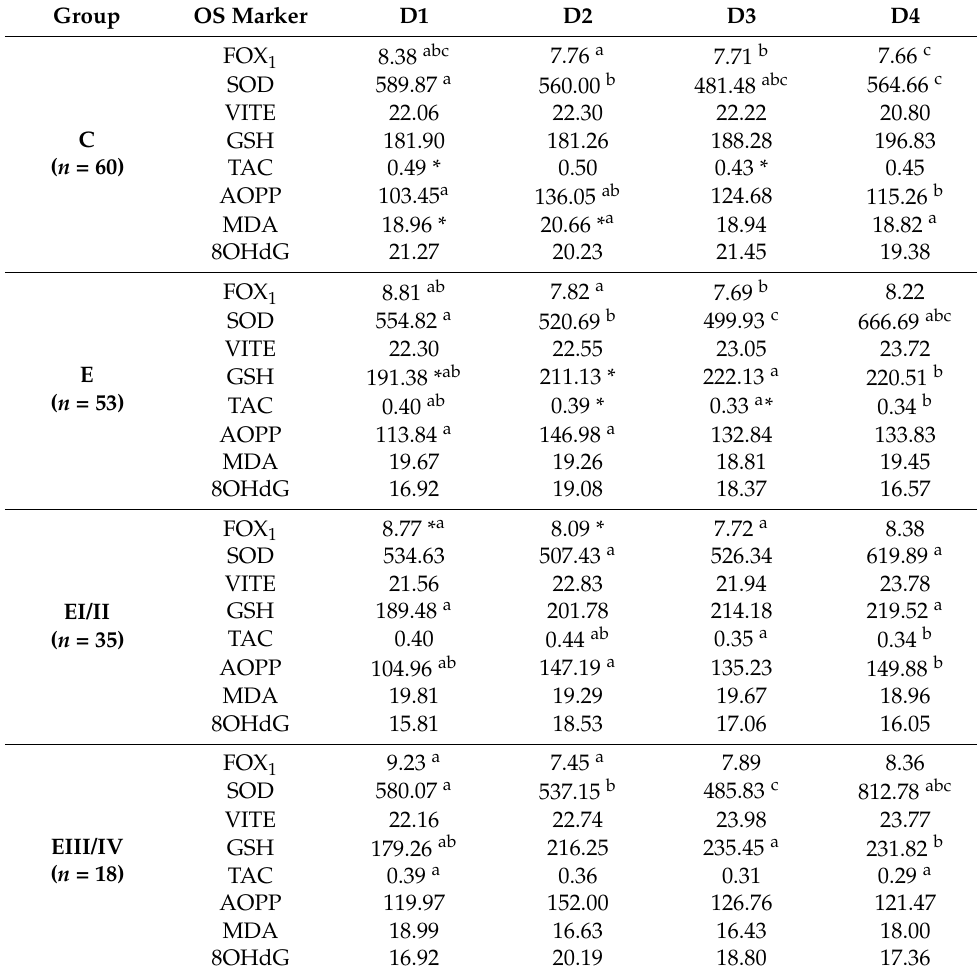
Table 3. Oxidative stress (OS) markers in serum samples obtained during the early follicular phase of the natural cycle prior to the beginning of controlled ovarian stimulation for ICSI (D1), after pituitary downregulation with the GnRHa (D2), after hCG administration (D3), and on the day of oocyte retrieval (D4), comparing the four timepoints within each group: infertile women with endometriosis (regardless of disease staging—E), with early endometriosis (EI/II), and with advanced endometriosis (EIII/IV), and infertile controls